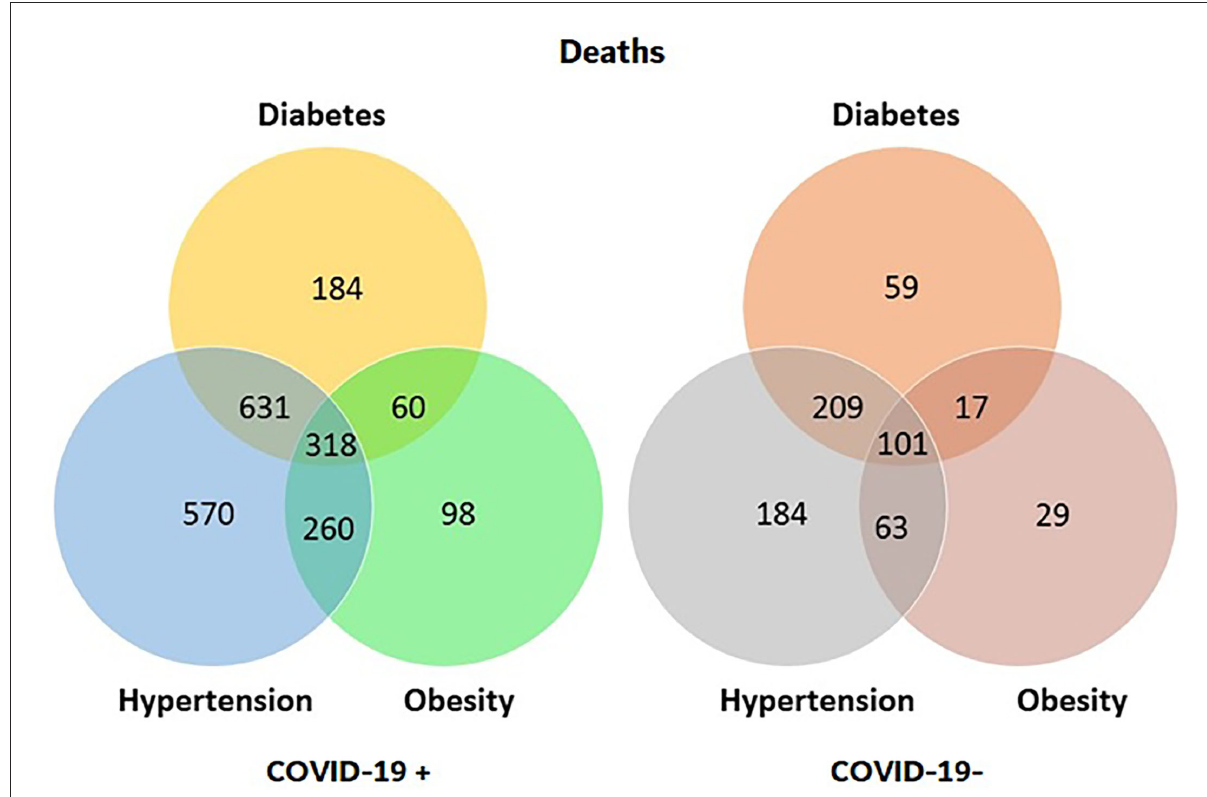
FIGURE2 Diagrams of total deaths for patients with CVD, divided by COVID-19 diagnosis, with values of comorbidities either individually or combined.